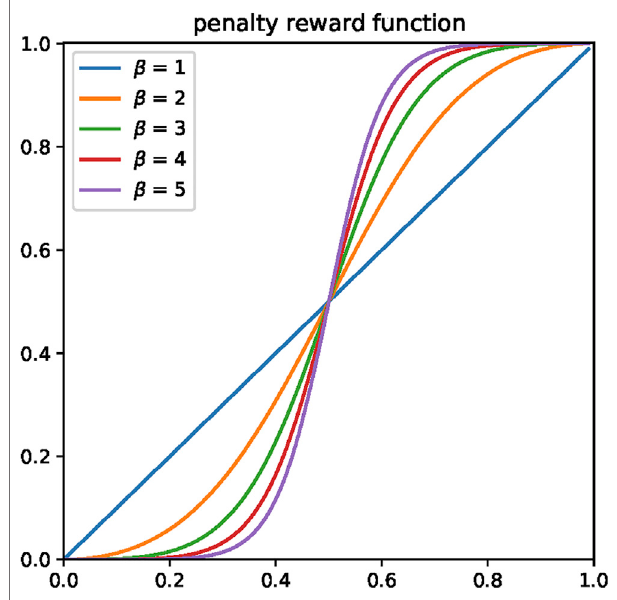
FIGURE 1 | Presentation of the penalty reward function with different parameters β